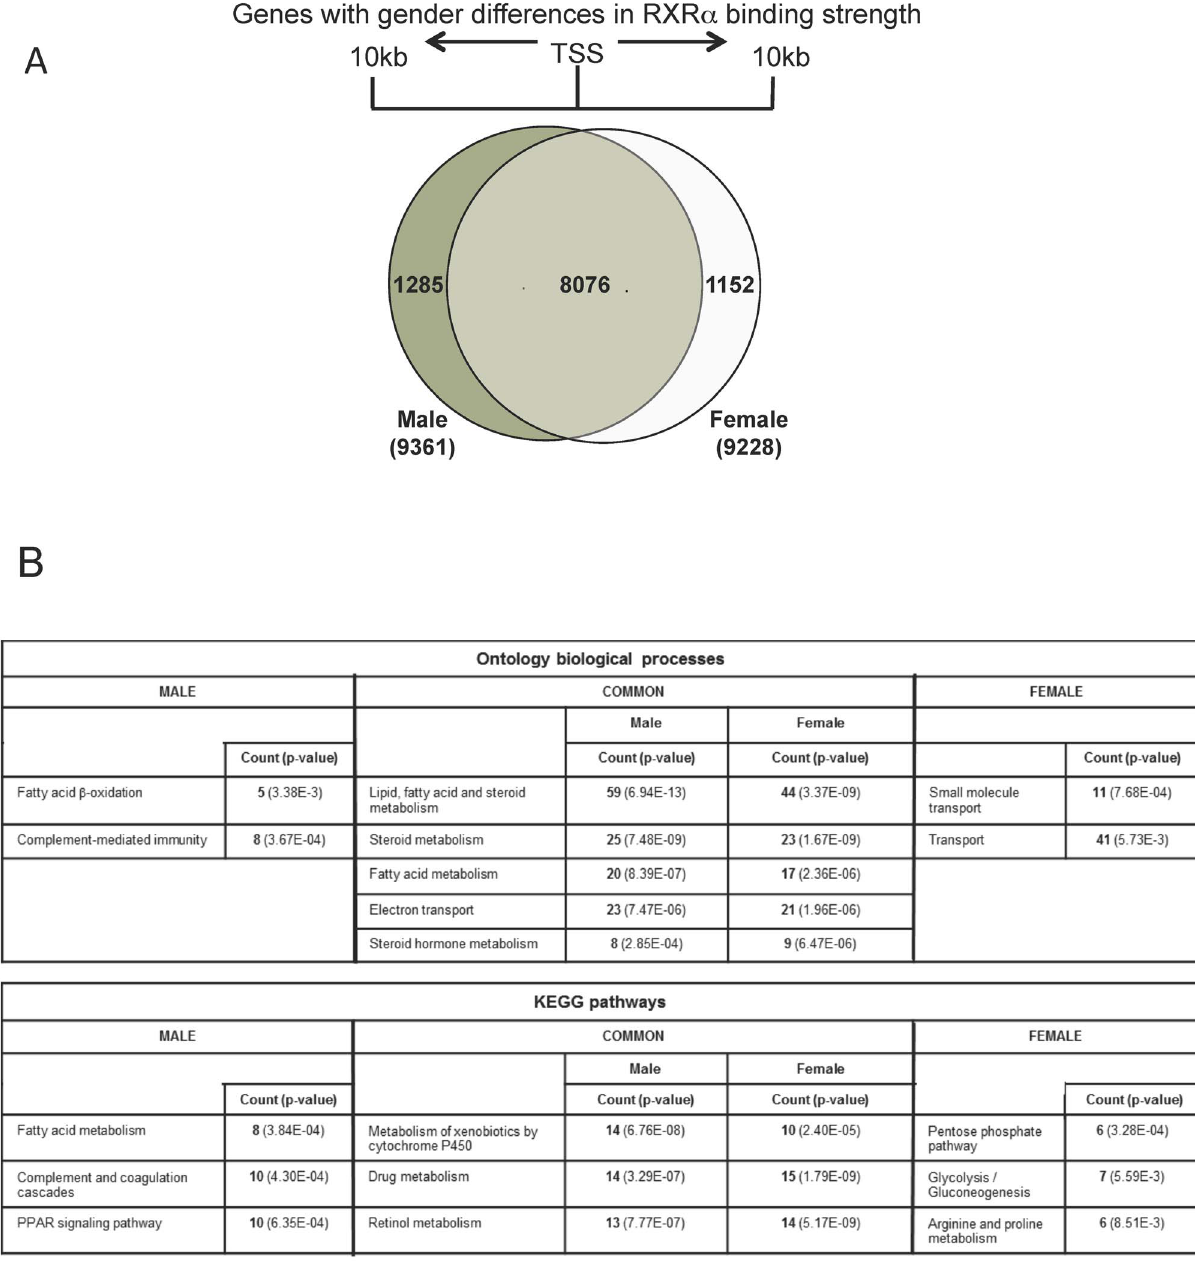
Figure 2. RXR a and Pol2 binding sites in mouse liver 10 kB surrounding the Transcriptional Start Sites. A) Venn diagram showing number of genes with shared RXR a regulation between male and female within 10 kB up and downstream of TSS, with 1285 genes found in male only and 1152 regulated by RXR a in females (see also Table S3A–D in File S1). B) Ontology analysis and pathway analysis of RXR a peaks with score . 6 or ,2 6 located within + / 2 10 kB of TSS (see also Table S3E–F in File S1).